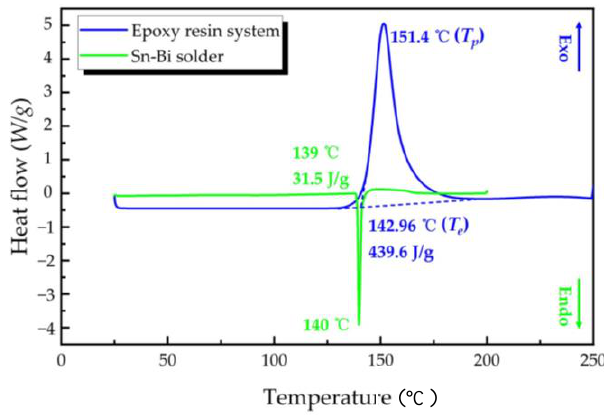
Figure 4. DSC thermogram of the curing behavior of the epoxy resin system and the melting curve of the Sn–Bi solder.